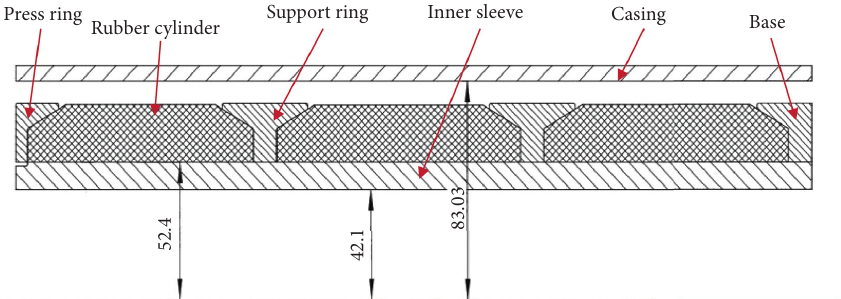
Figure 7: Structure dimensions of sealing